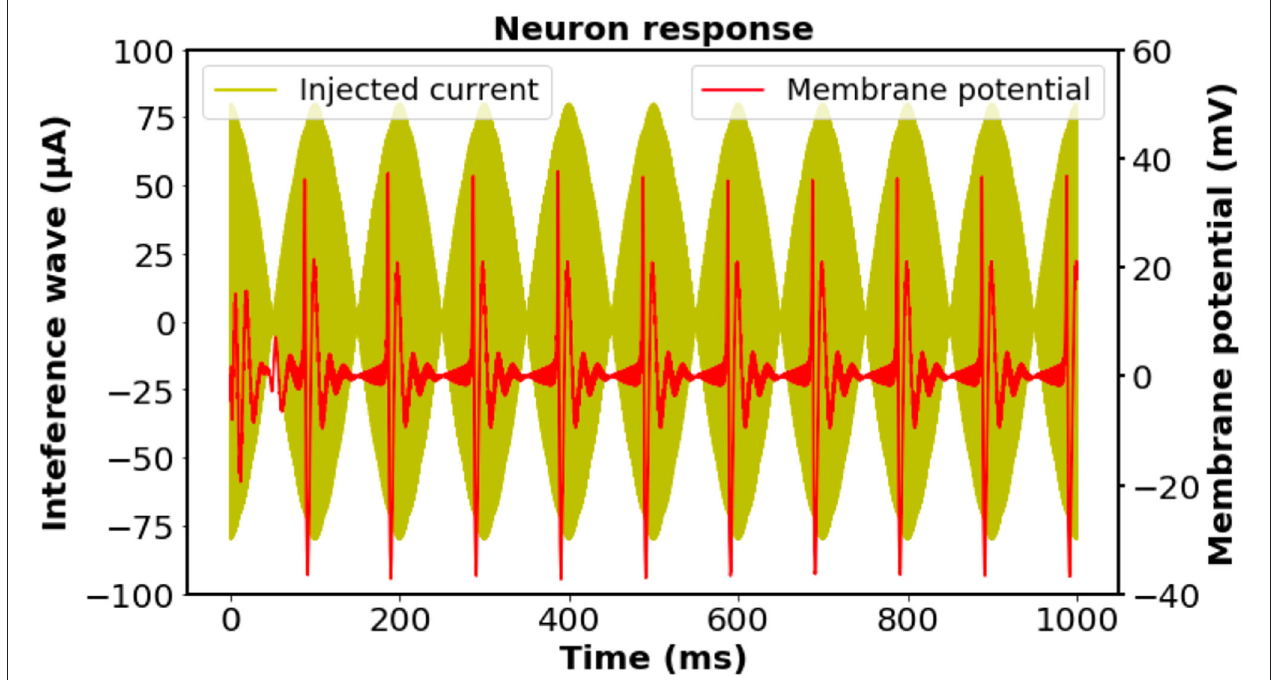
FIGURE 2 | Investigation of the biological neuronal response and the time-matched stimulus at the designed frequency according to the regular-spiking neuron model. The intensity of each external current was set to be the same, while the total current intensity was adjusted to have a reasonable value. The neural response was filtered by a fourth-order Butterworth bandpass filter with cut-off frequencies of 50 and 500 Hz to remove the stimulation artifacts. A 10 Hz oscillation of the membrane potential was observed, which was consistent with the frequency of the interfering stimulation wave. Neuron parameters: length and diameter: L = d = 61.4 µ m, leak membrane conductance: g leak = 2.05 × 10 − 5 S / cm 2 , reversal potential: E leak = − 70.3mV, maximal conductance: ¯ g Na = 0.056 S / cm 2 , ¯ g Kd = 0.006 S / cm 2 , ¯ g M = 7.5 × 10 − 5 S / cm 2 . Spike threshold: V T = −